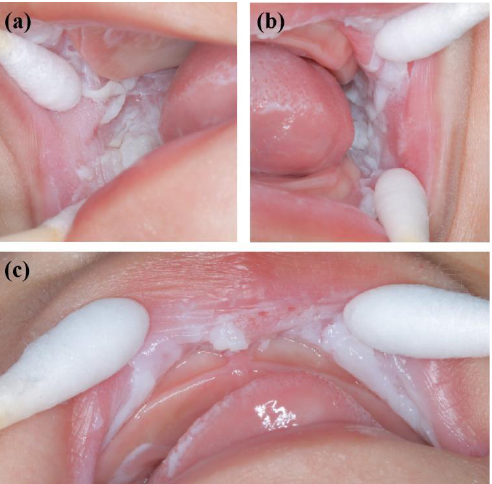
Figure 4. Oral manifestations of sister 2 showing large white corrugated folds in the ( a ) right and ( b ) left buccal mucosa and ( c ) inner mucosa of the upper lip, resembling a sponge.